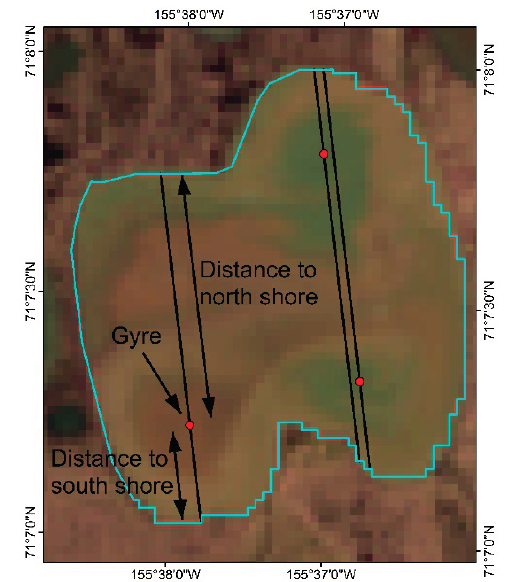
Figure 9. Measurement of the distance of gyres to the north and south shores of lake (Landsat 8 image in